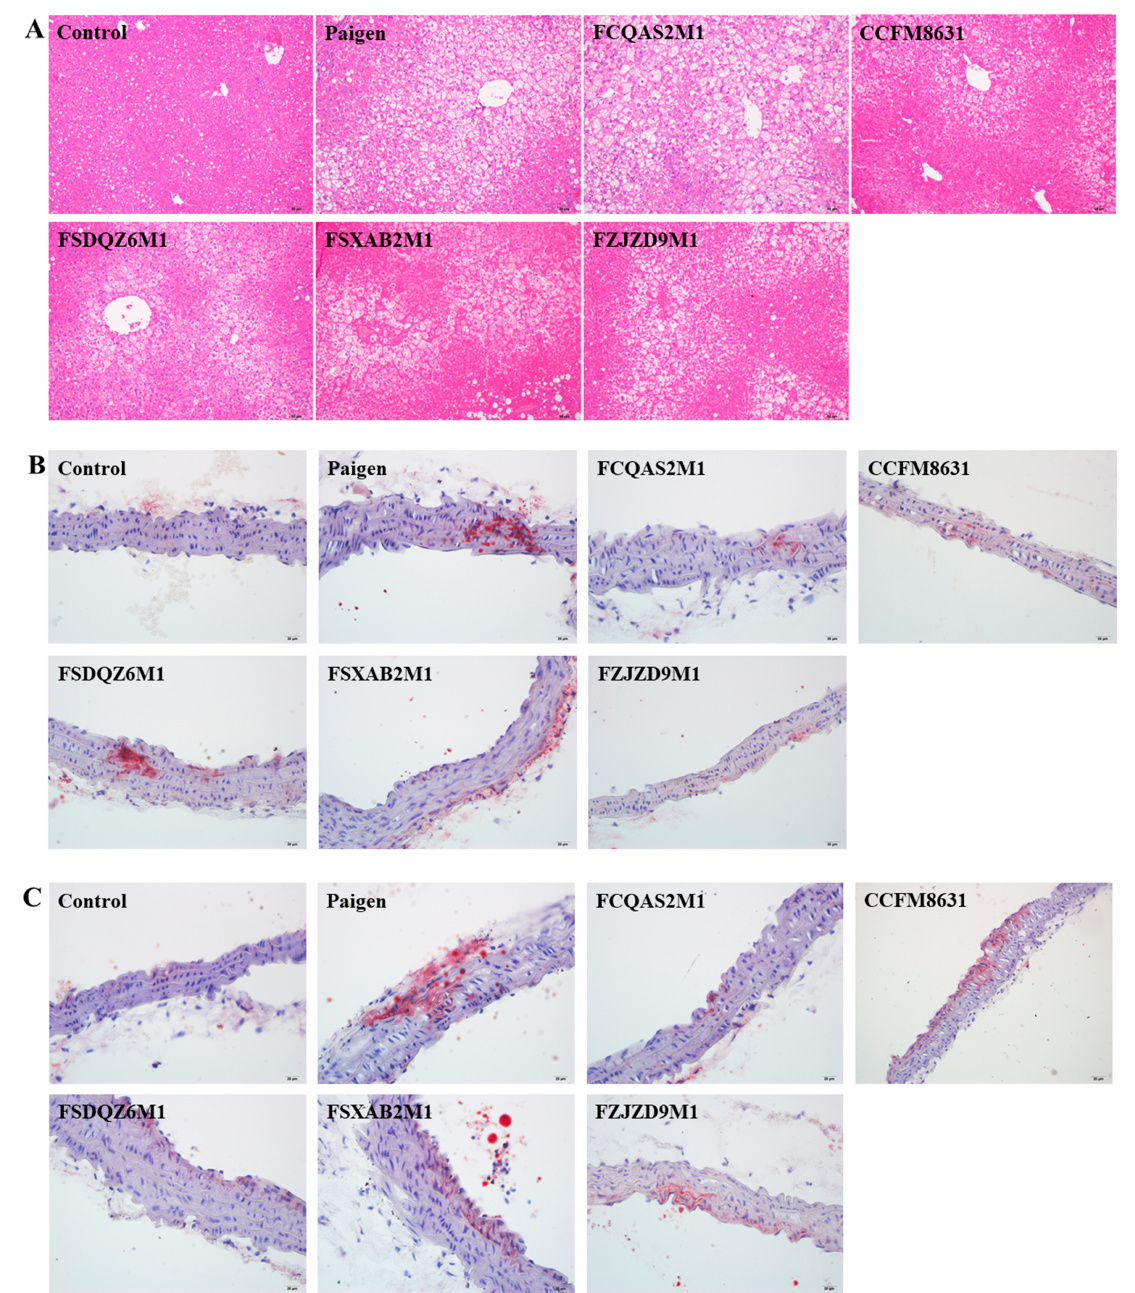
Figure 3. Histopathological analysis. ( A ) Liver HE staining. ( B ) Abdominal aorta oil red O staining. ( C ) Aortic arch oil red O staining. Specimens were photographed by light microscopy. (Magnification: × 200; HE staining, Scale bar: 50 µ m; Oil red O stain, Scale bar: 20 µ m). 3.4. Lactobacillus Reuteri CCFM8631 Significantly Affected the Composition of Short-Chain